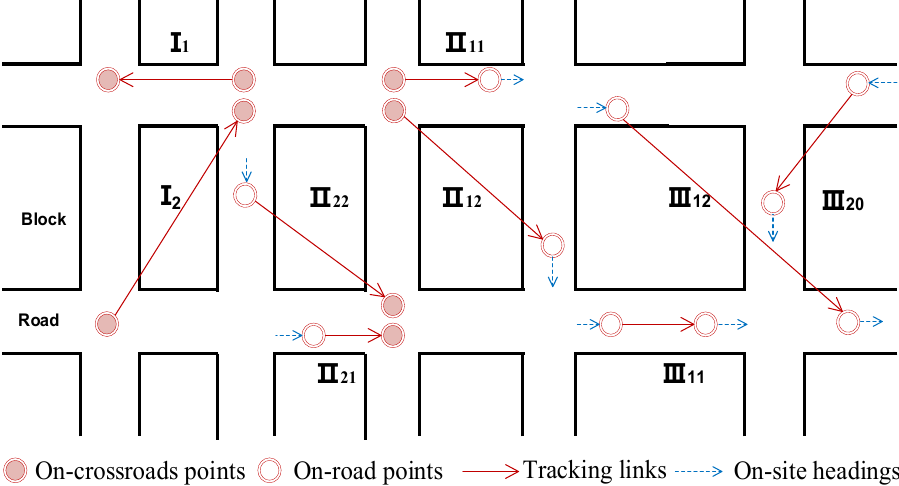
Figure 3. Spatial patterns of the tracking links, with normal links, i.e., I 1 , II 11 , II 21 , and III 11 , and shortcut outlier links, i.e., I 2 , II 12 , II 22 , III 12 , and III 20 .